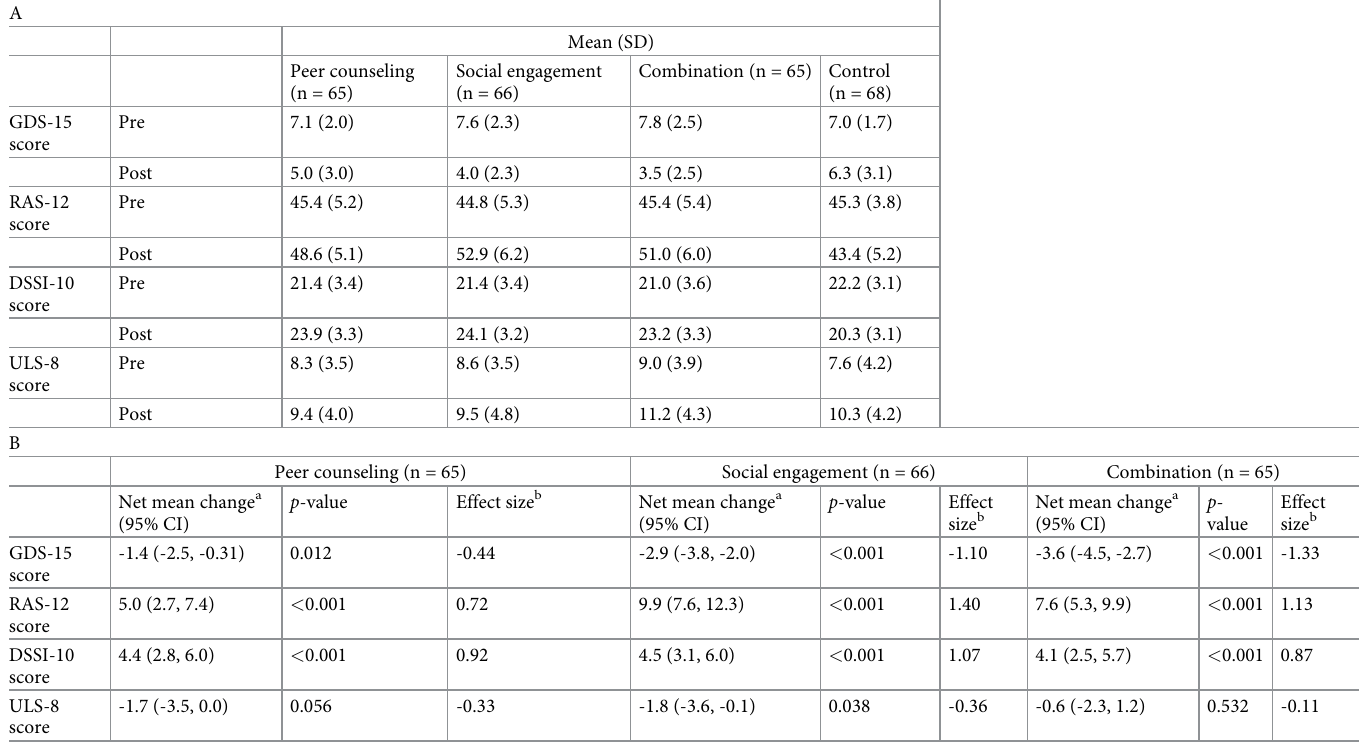
Table 2. Effects of intervention on the mental health outcomes of community-dwelling senior citizens at risk for depression.